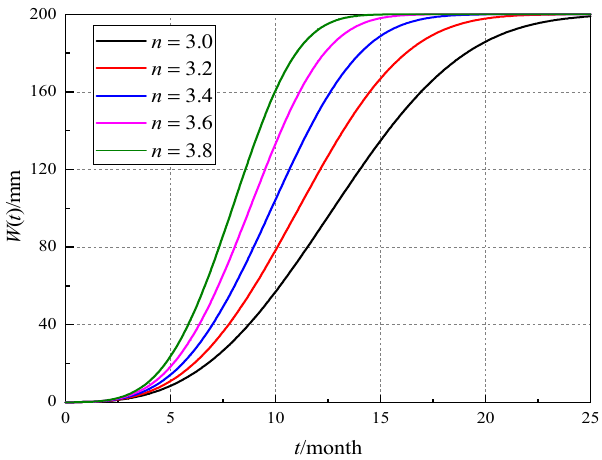
Figure 2. The influence of model order n on surface subsidence.